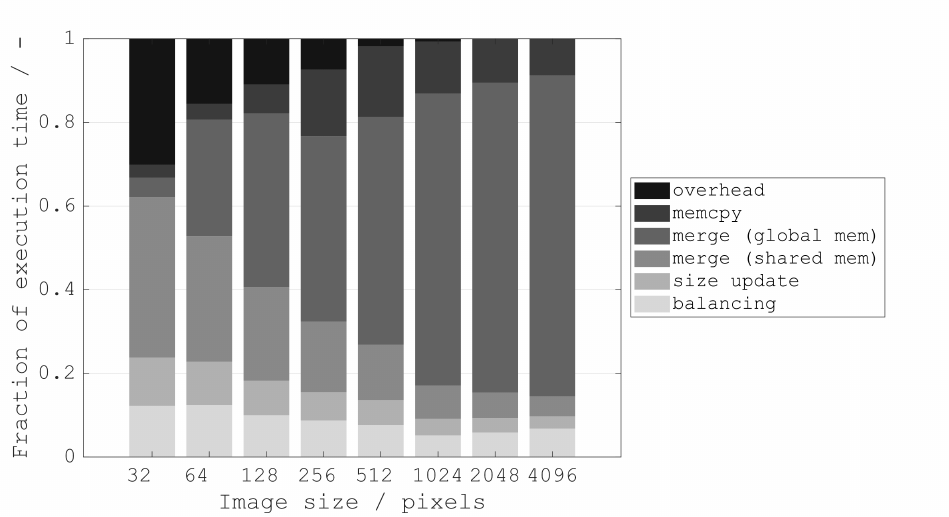
Figure 6. Fraction of kernel execution time for different image resolutions. Respective execution times are extracted using nsys . Overhead is calculated as remaining time between the sum of kernel execution times and total execution time, i.e., from start of the first kernel to the end of the final memcpy